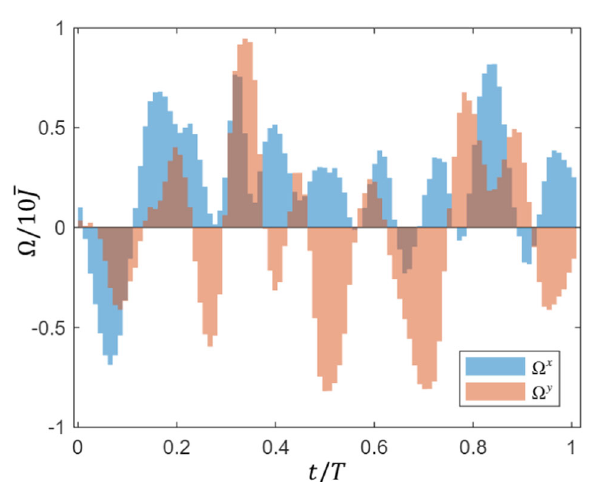
Fig. 5 Pulse shapes. Optimal pulse for the Hadamard gate at 1% uncertainty in Table 1. The gate duration is T ¼ 2 π = J .